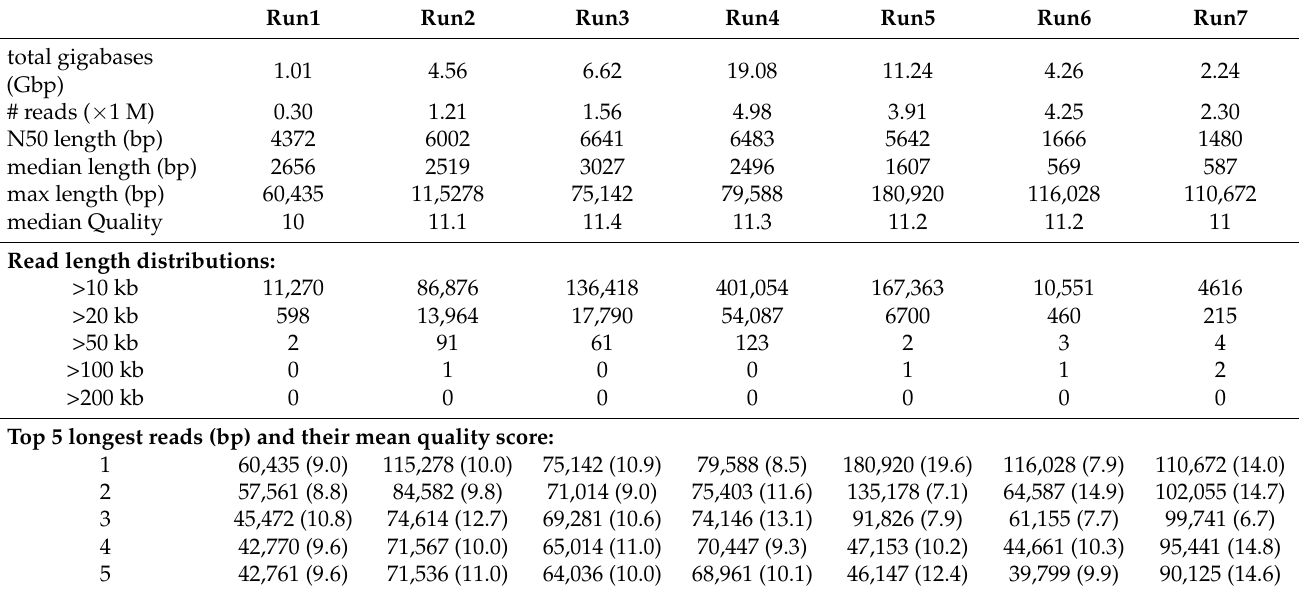
Table 2. Sequencing statistics for seven MinION runs with genomic DNA samples from rooibos (Quality ≥